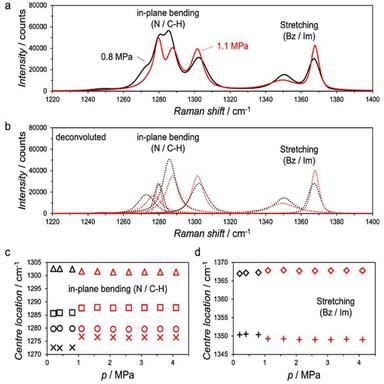
Vibrational mode analysis of ZIF-7 in methane across the gate opening (breathing) transition. (a) Acquired spectra of the in-plane bending mode of the (N/C-H) bond for imidazole rings and a stretching mode of the benzene and imidazole rings (Bz/Im). (b) Peak deconvolution of the spectra shown in (a) and peak center analysis (c-d) indicating the change in response across the transition pressure of 1.04 MPa.